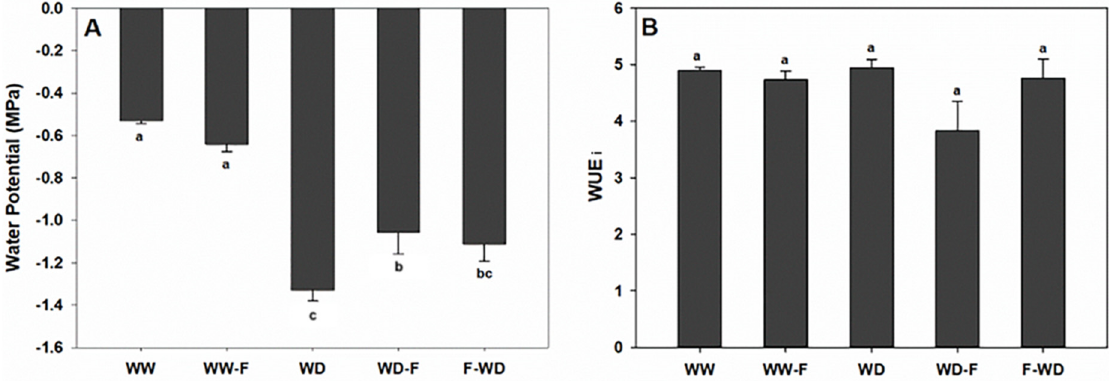
Figure 2. Midday stem water potential (( A ): Ψ md ) and water use efficiency ( B ) of grapevines exposed to WW (well-watered control); WW-F (well-watered fungal inoculation); WD (water deficit); F-WD (inoculation before water deficit); WD-F (inoculation after water deficit). Different lowercase letters indicate significant differences among the five treated groups ( p ≤ 0.05).